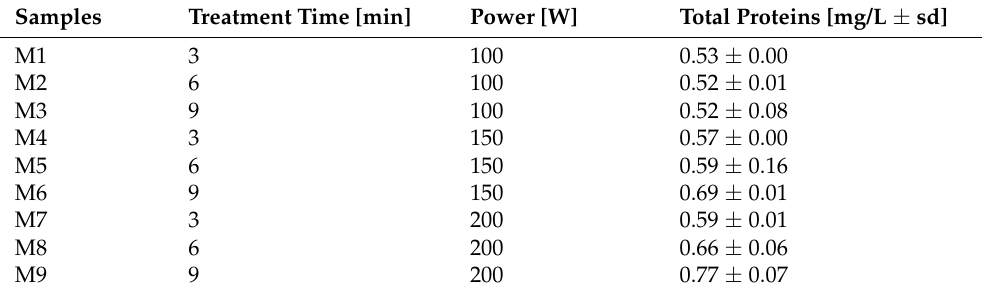
Table 5. Total protein concentration (mg/L ± sd) in a CS sample treated with microwave power.